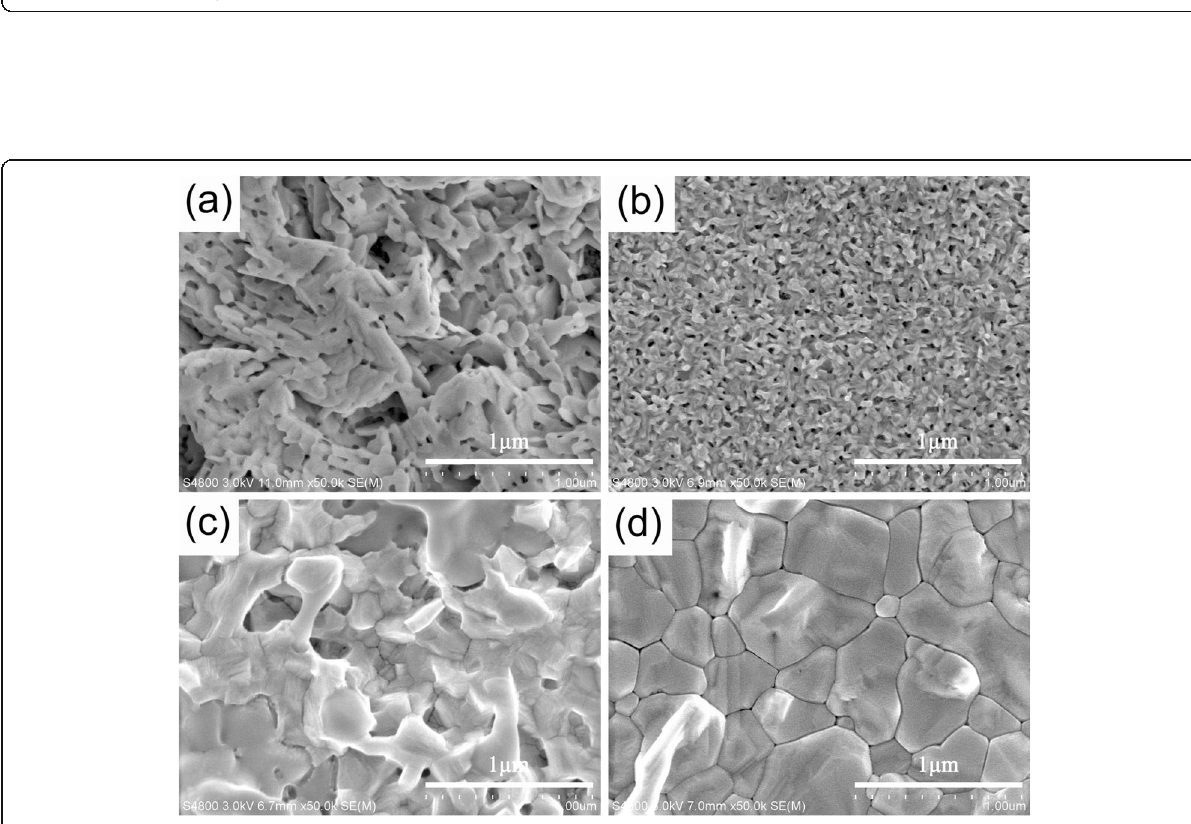
Fig. 2 Box Charts of a V OC , b J SC , c FF, and d PCE for mesoporous PSCs prepared under different RHs at 30 °C without the adding of BTA during the two-step spin-coating of perovskite films